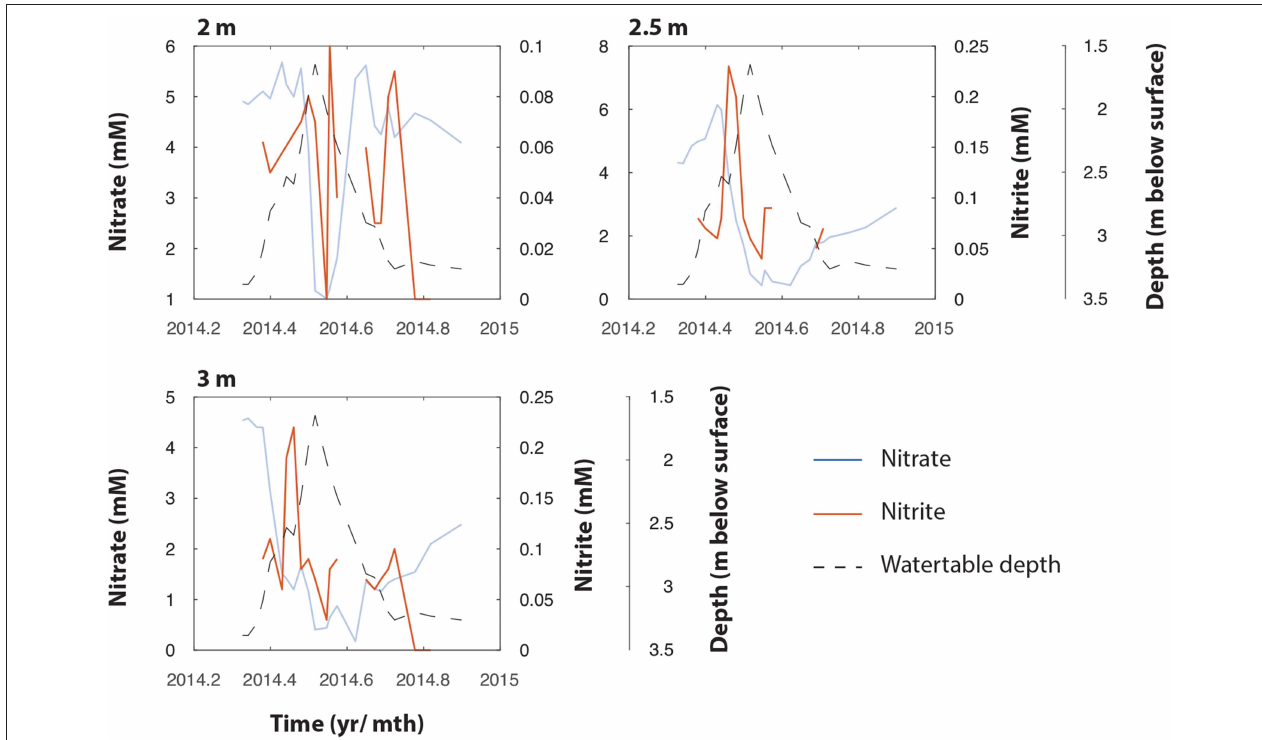
FIGURE 3 | NO 3 − (right axis) and NO 2 − (left axis) measurements at 2.0, 2.5, and 3.0 m bgs in TT-03 during 2014. The plots show coincidental and temporally lagged production of NO 2 − as NO 3 − declines, followed by apparent loss of NO 2 − . The water table depth is represented by the black dotted